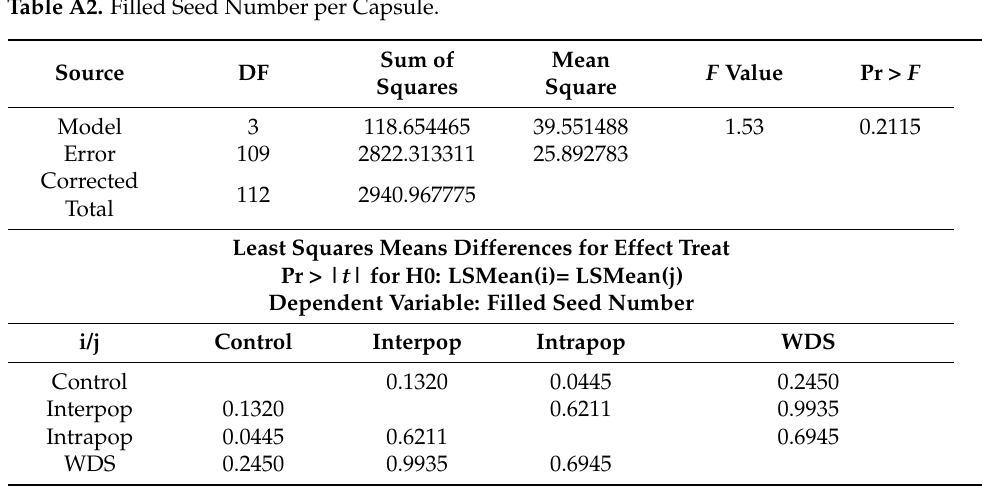
Table A2. Filled Seed Number per Capsule.